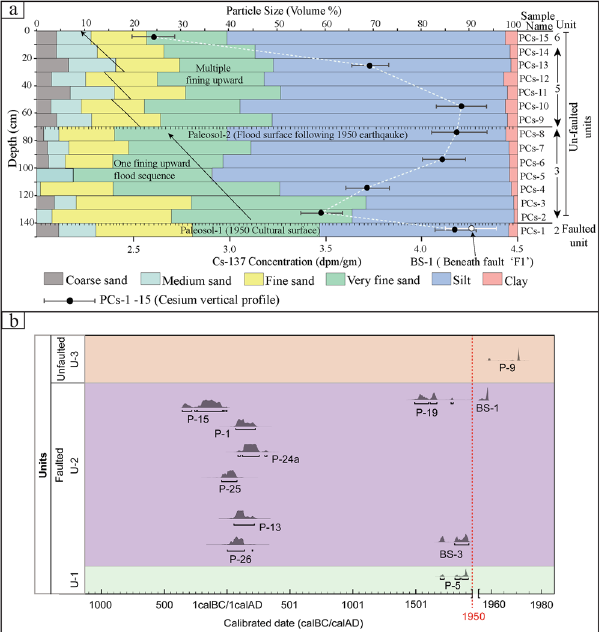
Figure 4. ( a ) Multi-variable vertical profile plot between grain size and 137 Cs concentration as a function of depth (stratigraphy) in the Pasighat trench exposure. Black dots with lines on either side indicate the 137 Cs concentration in the depth profile and its uncertainty. The sample BS-1 (white dot) from unit-2 palaeosol beneath fault ‘F1’ shows high Cs and 210 Pb xs concentration; high Cs concentration corresponds to the high clay content. ( b ) Probability Density Function (PDF) plot of radiocarbon samples obtained from the Pasighat trench exposure showing timing of the event. Plot generated in OxCal v4.3.1 online